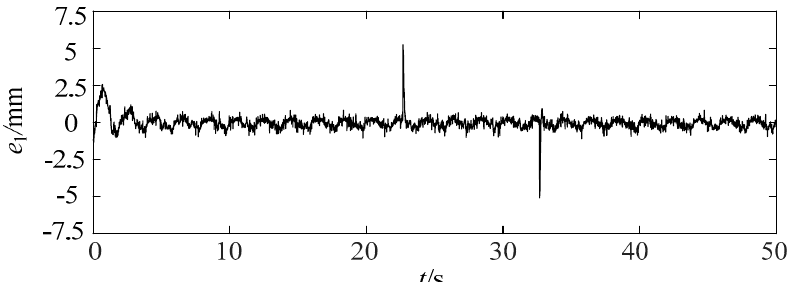
Figure 9. Tracking error of the proposed controller for 0.5 Hz sinusoidal trajectory with disturbance.